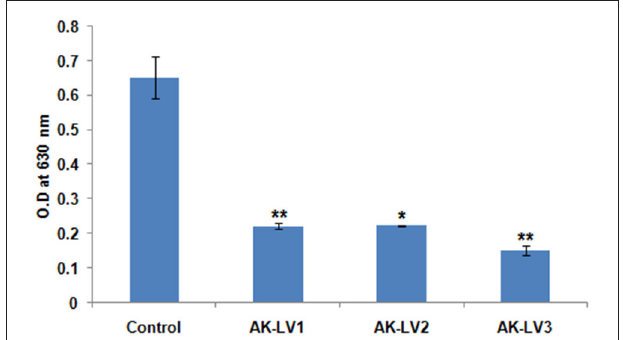
FIGURE 3 | Effect on biofilm formation of control and knockdown strains (AK-LV1, AK-LV2, and AK-LV3). The data represents an average of triplicate